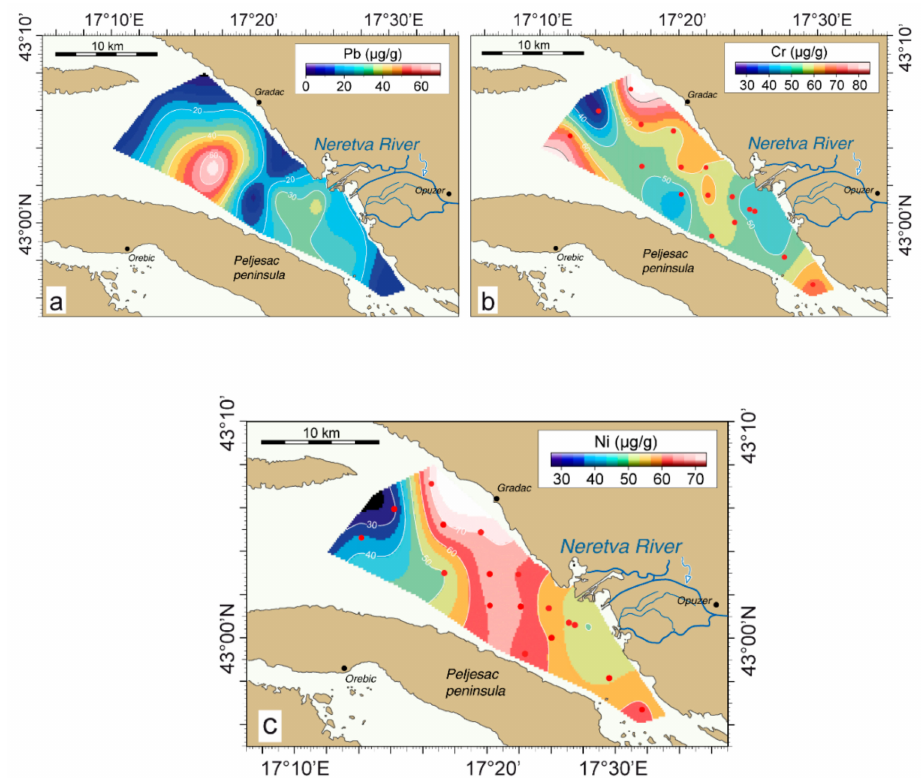
Figure 5. Surficial distribution of ( a ) Pb, ( b ) Ni and ( c ) Cr